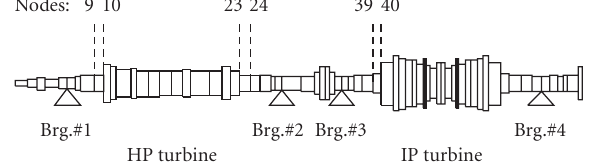
Table 3: Position of the equivalent bending moments.